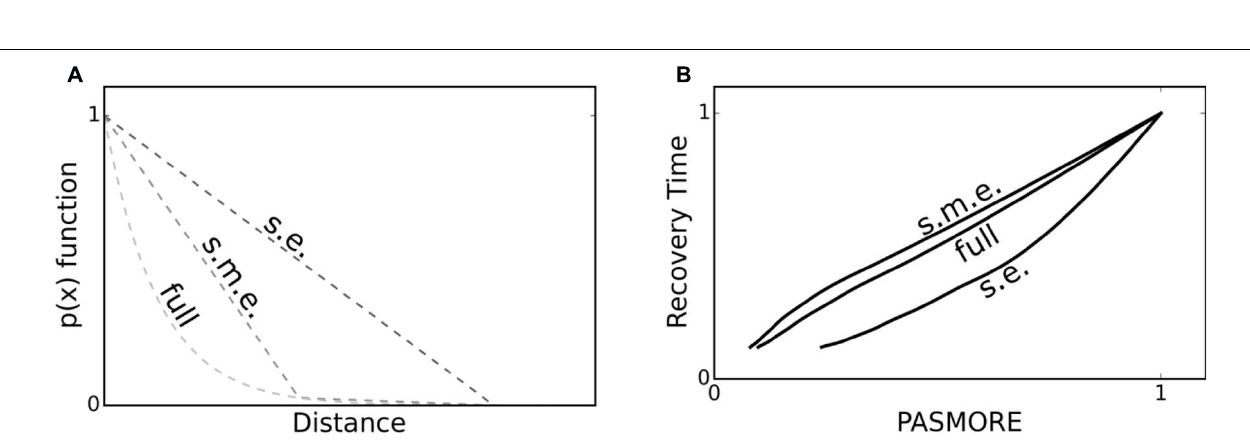
FIGURE 5 | In some cases, a full perturbation profile, i.e., p(x) , may not be known. However, it may be possible to make a few measurements and interpolate the perturbation profile, for example at the start and end of the perturbation profile. (A) Three demonstration cases for a measured perturbation profile: Start and end (s.e., linear approximation), start-middle-end (s.m.e., two linear lines approximation), and full profile (full, exponential). (B) Recovery Time – PASMORE correlation to the three measured perturbation profiles. Even in the cases where only limited information about the true perturbation profile is known, PASMORE may still correlate well with recovery